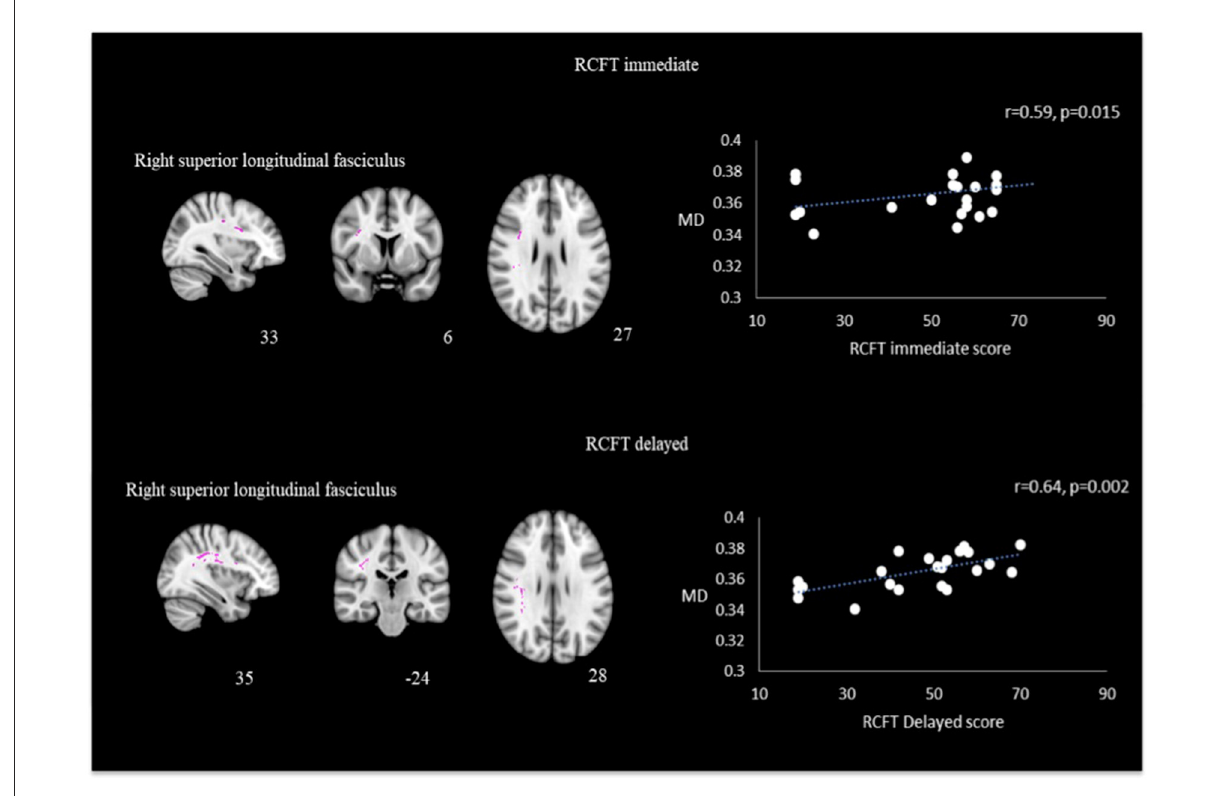
FIGURE5 Correlation between MD and RCFT immediate and delayed scores in the right superior longitudinal fasciculus in TBI